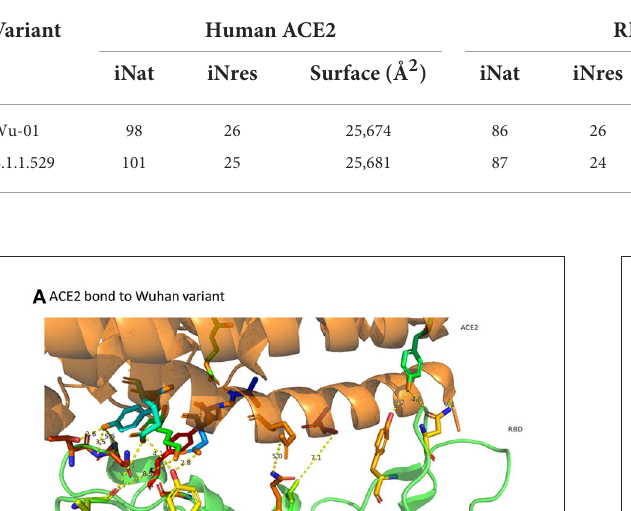
TABLE 4 Summary of global interactions between spike proteins and human ACE2 protein of both variants involve in the study.